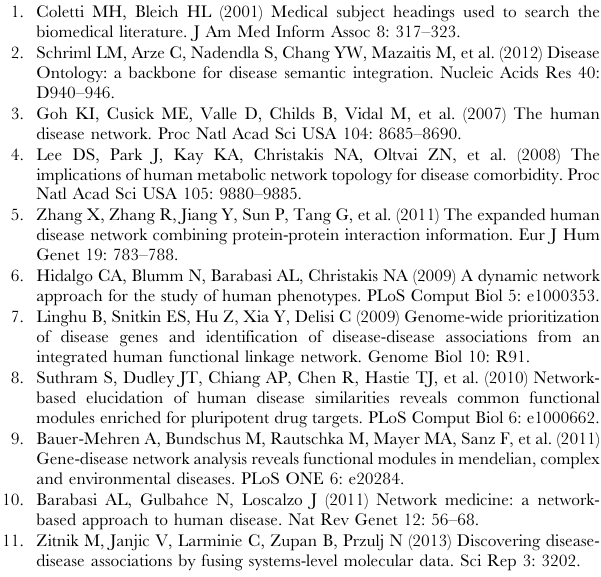
(B) R, as a function of number of iterations. R is minimized after 10 iterations. Figure S2 , Empirical p-values vs p-value cutoffs. times. Figure S3 , The probability of finding shared KEGG pathways is plotted (in red) as a function of average MimMiner score (a) or average correlation (b). The blue line shows the fitted piecewise function. The separation points are considered the cutoffs above which the scores or correlations are